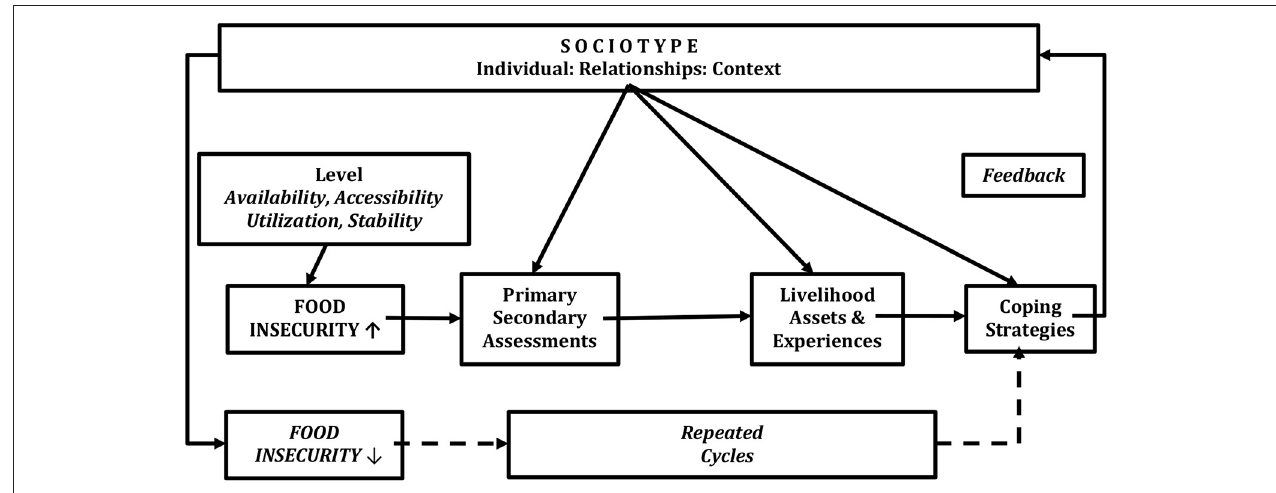
FIGURE 2 | The Sociotype is involved with both the dynamic assessment of the Stresses of Food Insecurity and the Coping strategies to deal with